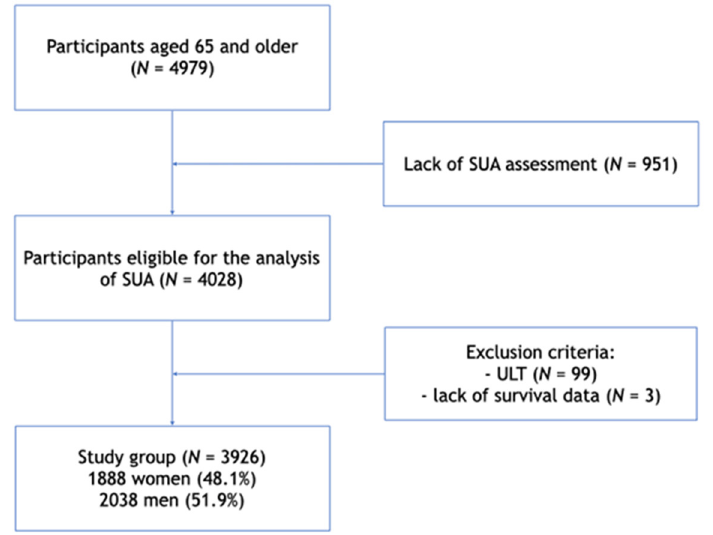
Figure 1. Flow chart. SUA—serum uric acid, ULT—urate-lowering therapy (treatment with xanthin oxidase inhibitors).